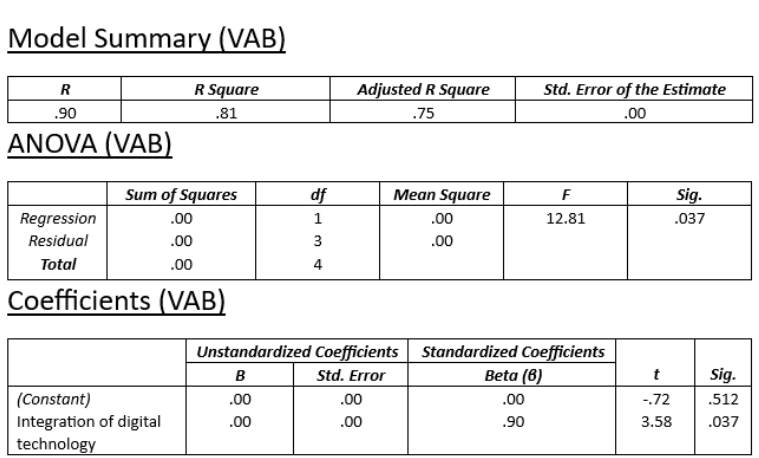
Figure 13. Linear regression: digitalization and gross value added—Romania.